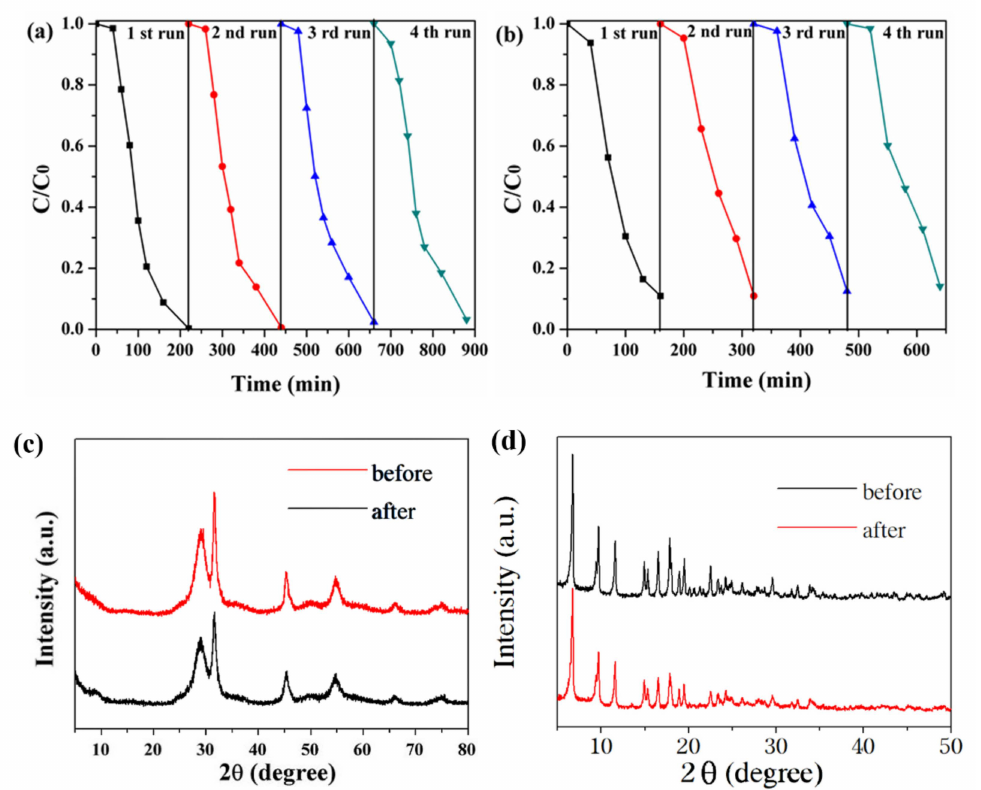
Figure 10. Reusability of BNMT-9 for the photocatalytic degradation of ( a ) RhB and ( b ) P-CP, and ( c ) XRD diagram of BNMT-9 and ( d ) NH 2 -MIL-125(Ti) before and after the cyclic degradation of